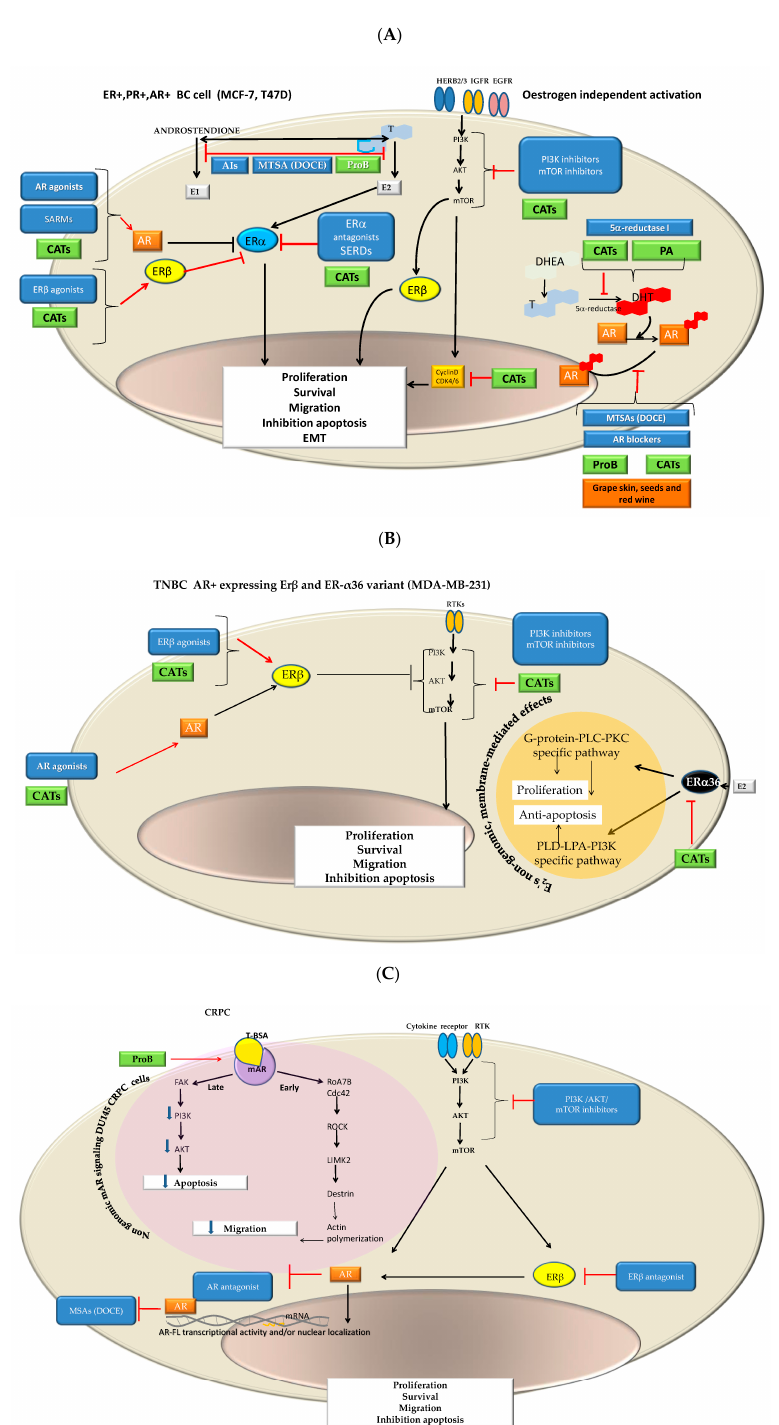
Figure 12. Schematic representation of proposed mechanism by which CAT and ProB2 with and without DOCE could promote anti-tumor effects. Panels ( A ), ( B ) and ( C ) show therapeutic targets in BC and PC with the corresponding drugs used in clinical practice (boxes in blue). Likewise, the targets on which CATs and/or ProB (green boxes) can act are ob- served. Black truncated arrows and lines indicate mechanisms that stimulate tumor growth and invasion. Red truncated arrows/lines show the effects of drugs as well as CAT/ProB. Therapeutic targets depending on the type of BC and PC are based on Karamouzis et al. [119] with modifications. It is observed how the different targets and mechanisms vary de- pending on the cellular characteristics. Based on this aspect, different cell sensitivity can be expected under single (CAT, ProB, DOCE treatment) or co-adjuvant treatment (CAT plus DOCE or ProB2 plus DOCE). Panel ( A ) represents ER+, PR+, AR+ BC (MCF-7 and T47D cells) while panel ( B ) represents TNBC BC (MDA-MB-231 cells). Orange circle represents E2’s non-genomic, membrane-mediated effects according to Chaudhri et al. [120]. Panel ( C ) represents CRPC (DU-145 and PC3 cell lines). The circle in purple color corresponds to the schematic representation of non-genomic mAR signaling in DU145 CRPC based on Papadopoulou et al. [121]. Meanwhile, BC and PC are hormone cancers; different hormones such as es- trogens, progesterone and androgens are involved in their growth and metastatization. The pro-tumor effect of these hor- mones is largely established through their binding to their corresponding receptors. Therefore, the therapy of these cancers includes molecular target therapies such as selective modulators of hormone receptors as well as selective inhibitors of enzymes related to the synthesis of steroid hormones [75,122]. Namely, selective ER modulators (SERMs), selective ER down-regulators (SERDs), selective PR modulators (SPRMs), selective androgen receptors modulators (SARMs), aroma- tase inhibitors (Ais) and 5 α -reductase inhibitors, represented in panels A, B and C. SERMs, by binding to the ER, prevent binding of estrogens to that receptor and thereby estrogen-stimulated cell proliferation, whereas SERDs down-regulate the ER. SAMRs interact with AR, preventing tumor growth and metastatization. AIs inhibit the synthesis of estrogens (aromatase enzyme is involved in the conversion of the testosterone to estradiol). 5 α -reductase converts testosterone into a more active androgen called 5 α -DTH and also metabolizes progesterone to 5 α DHP, being an important regulator of androgens and progesterone effects. Testosterone and 5 α -DTH bind to AR and induce prostate hypertrophy as well as PC. 5 α -reductase inhibitors block 5 α -DTH production. CATs, by acting on hormonal receptors, could have pharmacolog- ical actions similar to those of modulators of these receptors (SERMs, SERDs, SPRMs, SARMs) [66–75,82]. In addition, they would act by inhibiting aromatase [76–79] or 5- α reductase [81]. DOCE causes AI in luminal BC cells and alters AR tran- scriptional activity and/or nuclear localization (panel A). Furthermore, the belief that DOCE acts by interfering with the mechanism of action of AR is reinforced. DOCE could prevent AR translocation into the nucleus. Indeed, there is correla- tion between clinical response and AR cytoplasmic retention in circulating tumor cells isolated from mCRPC treated with DOCE [123]. Abbreviations: AIs, aromatase inhibitors; Akt, protein kinase B; AR, androgen receptor; BSA, bovine serum albumin; CAT, catechin; CRPC, castrate resistant prostate cancer; DHEA, dehydroepiandrosterone; DHP, dihydroproges- terone;DHT, dihydrotestosterone; DOCE, docetaxel; ER α , estrogen receptor alfa; E1, oestrone; E2, oestradiol; EGFR, epi- dermal growth factor receptor; ER β , estrogen receptor beta; FAK, focal adhesion kinase; HERB2, human epidermal growth factor receptor 2; HERB3, human epidermal growth factor receptor 3; IGFR, insulin-like growth factor receptor; LIMK2, LIM domain kinase 2; LPA, lysophosphatidic acid; mAR, membrane androgen receptors; MATs, microtubule-targeting